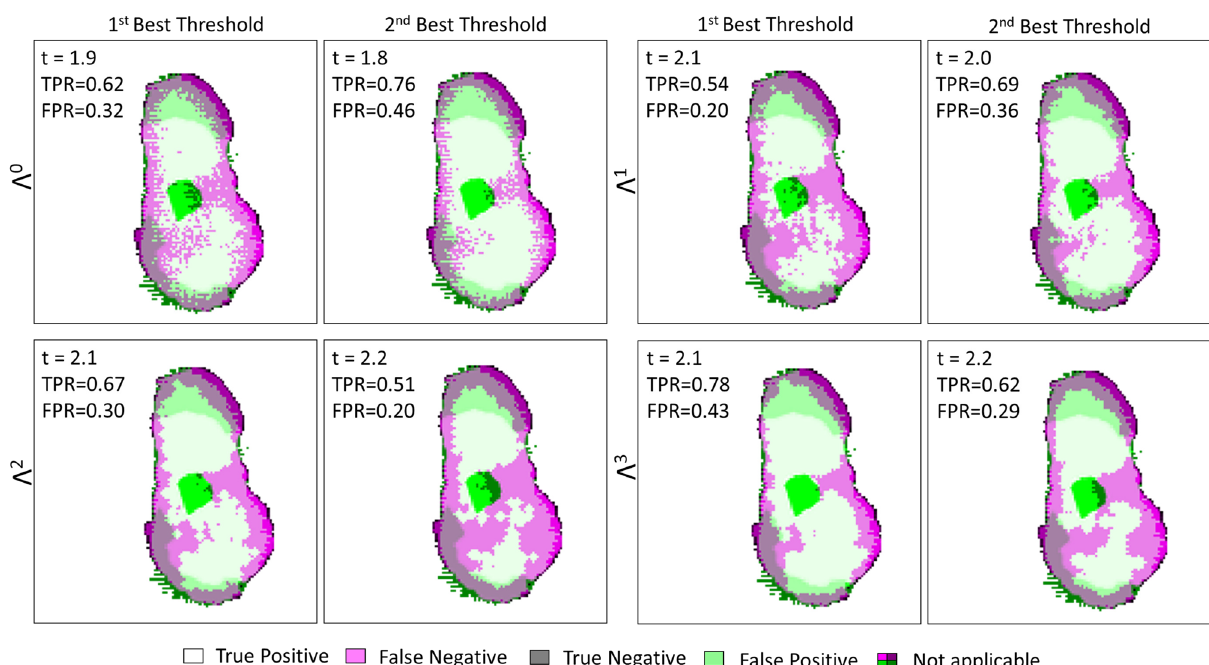
0 1 2 3 , (cid:31) , (cid:31) , (cid:31) and their respective first